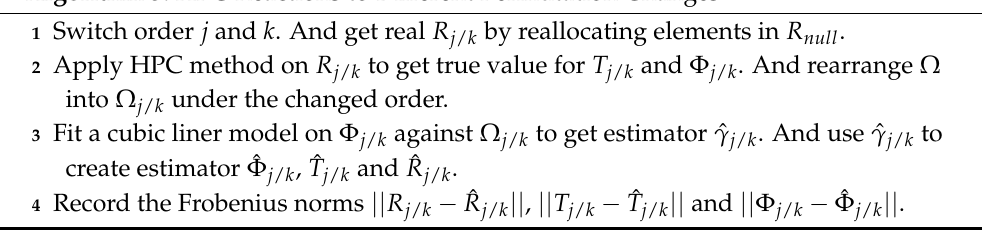
Algorithm 3: HPC Reactions to Different Permutation